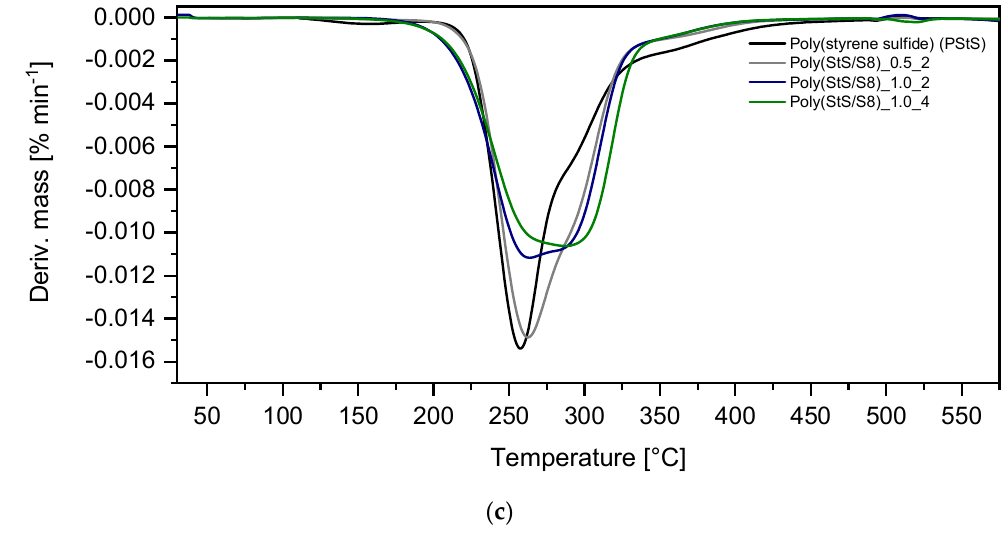
Figure 12. Thermal analysis of synthesized polysulfides ( a ) differential scanning calorimetry (DSC)—first heating scans; ( b ) thermogravimetry (TGA); ( c ) differential thermogravimetry (DTG). Table 4. Glass transition temperature and thermal stability of poly (StS) and poly (StS/S 8 ) copolymers. Sample Symbol T g 1 [ ◦